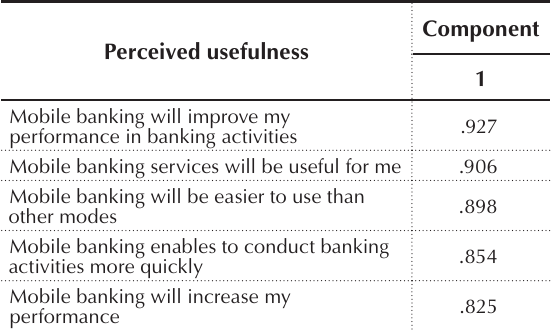
Table 3. (cid:38)(cid:258)(cid:272)(cid:410)(cid:381)(cid:396)(cid:3)(cid:258)(cid:374)(cid:258)(cid:367)(cid:455)(cid:400)(cid:349)(cid:400)(cid:3)(cid:381)(cid:374)(cid:3)(cid:393)(cid:286)(cid:396)(cid:272)(cid:286)(cid:349)(cid:448)(cid:286)(cid:282)(cid:3)(cid:437)(cid:400)(cid:286)(cid:296)(cid:437)(cid:367)(cid:374)(cid:286)(cid:400)(cid:400)